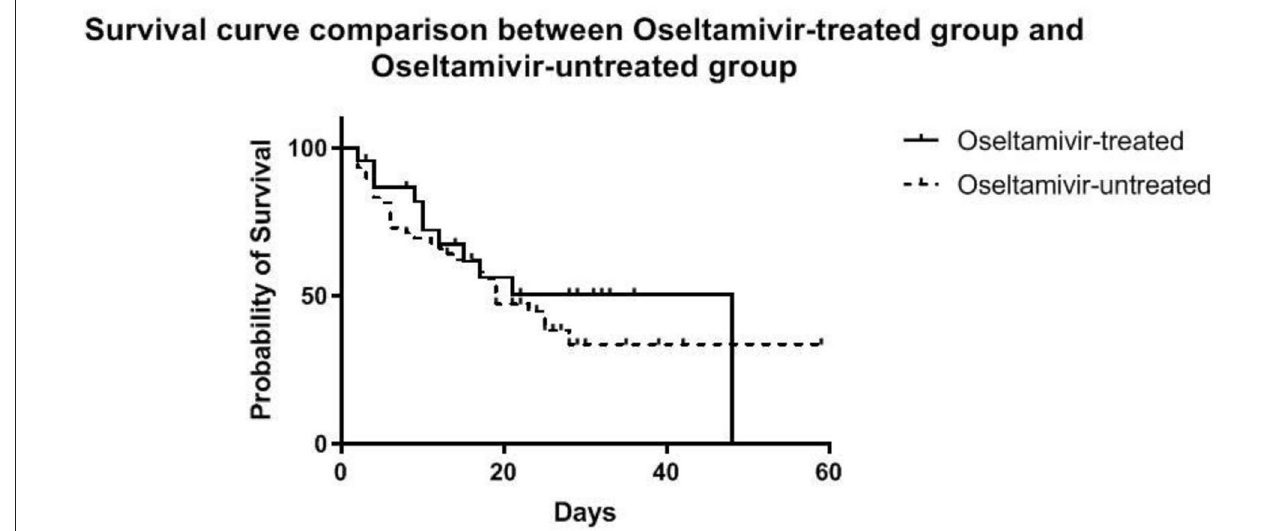
FIGURE 3 | Estimated survival of patients during VA-ECMO support until the time of discharge, stratified into the oseltamivir -treated and -untreated group.